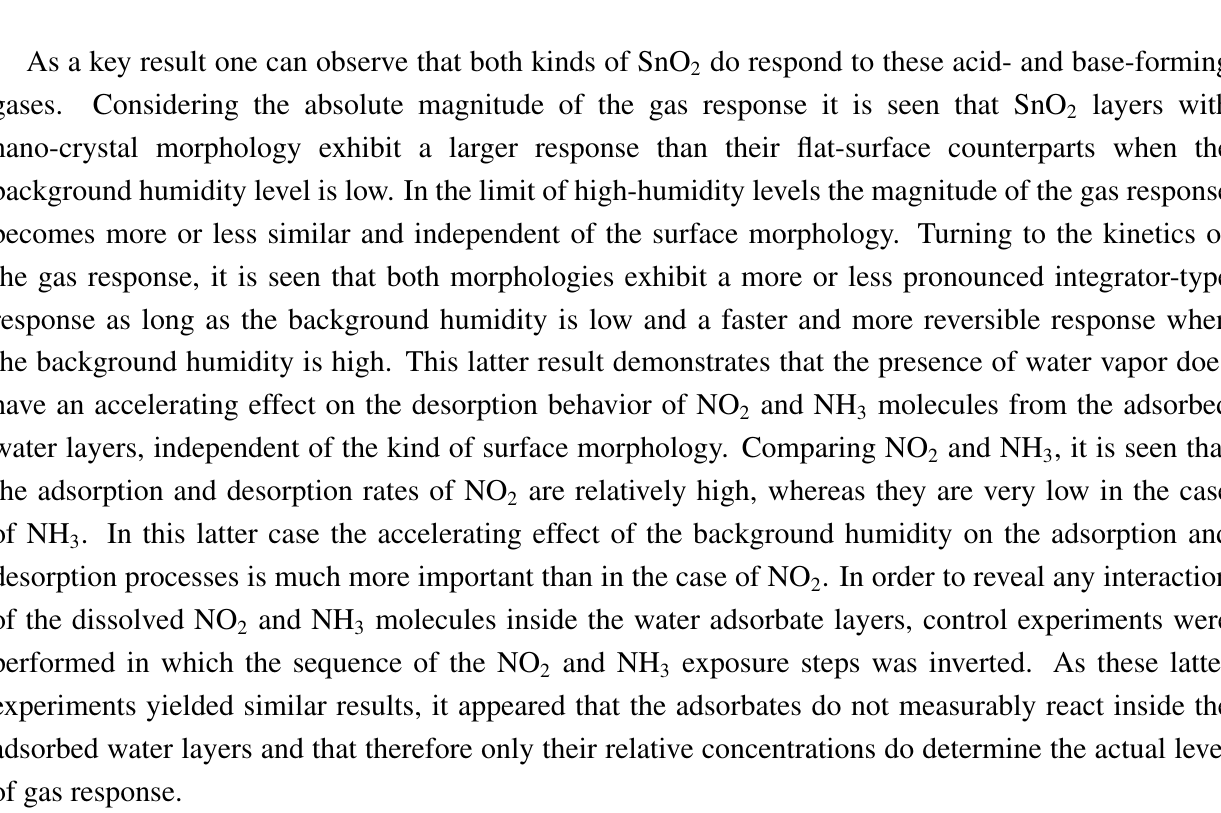
layers with a flat (red) and a nano-granular (black) surface 2 and NH exposure pulses in different humidity backgrounds 2 3